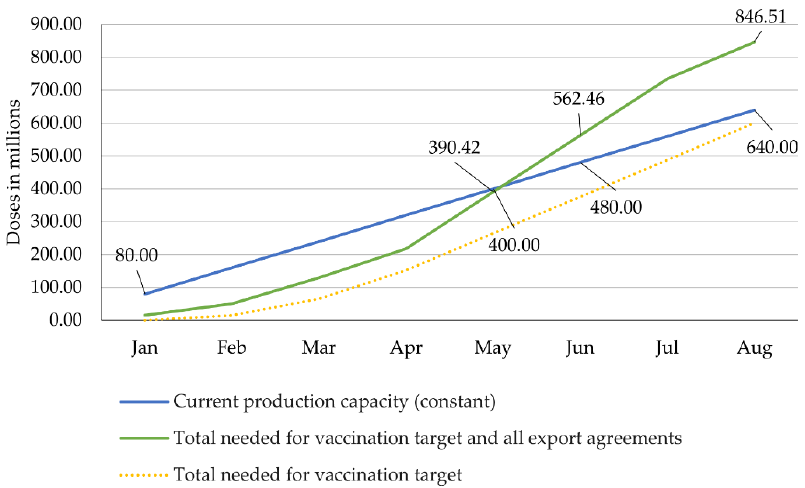
Figure 5. Constant production capacity vs. fulfilment of vaccination target and all export agree-